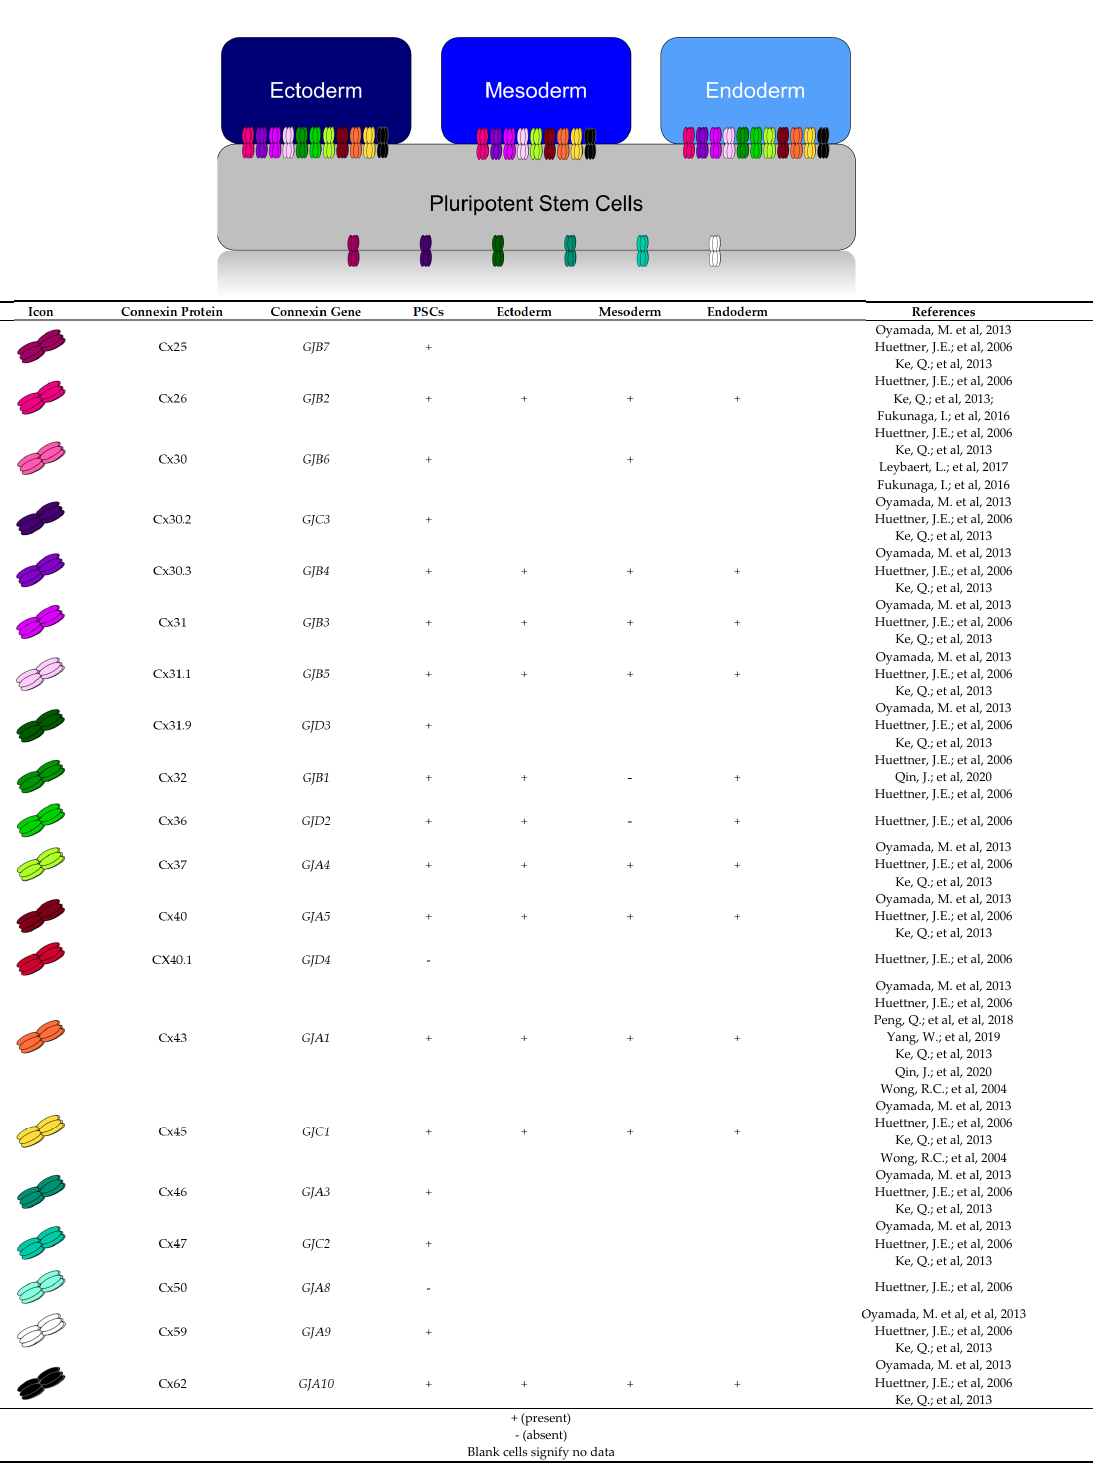
Figure 9. Human connexin expression profiles described in literature and this study. Human plu- ripotent stem cells express Cx40.1 [21] and Cx50 [21]. Cx23 expression in pluripotent stem cells and the three germ layers has not yet been characterized. Our study shows control iPSCs and the three germ layers express mRNA transcripts for Cx26 [21,38,51], Cx30.3 [7,21,38], Cx31 [7,21,38], Cx31.1 [7,21,38], Cx37 [7,21,38], Cx40 [7,21,38], Cx43 [7,21,22,27,38,43–45], Cx45 [7,21,38,45], and Cx62 [7,21,38]. Significant increases were viewed for mRNA transcripts of Cx62 in ectoderm; Cx45 in ectoderm and mesoderm; and for Cx30.3, Cx31, Cx32, Cx36, Cx37, and Cx40 in endo-derm. Transcripts for Cx32 and Cx36 were not detected in